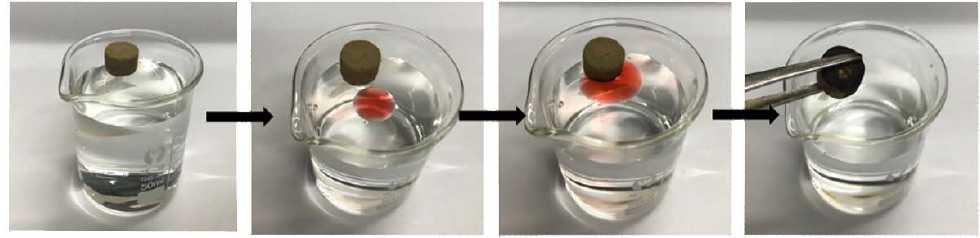
Figure 10. Removal of corn oil (dyed with Sudan red) from the water surface using MCPGA.